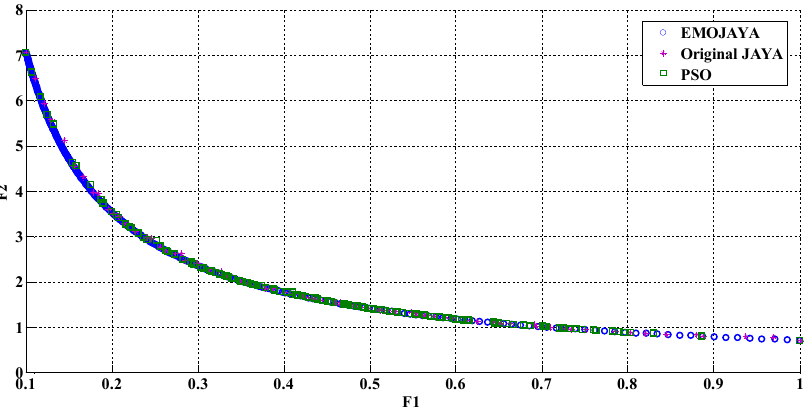
Figure 4. Comparison of the Pareto front from EMOJAYA, JAYA and PSO (Test Function 3).